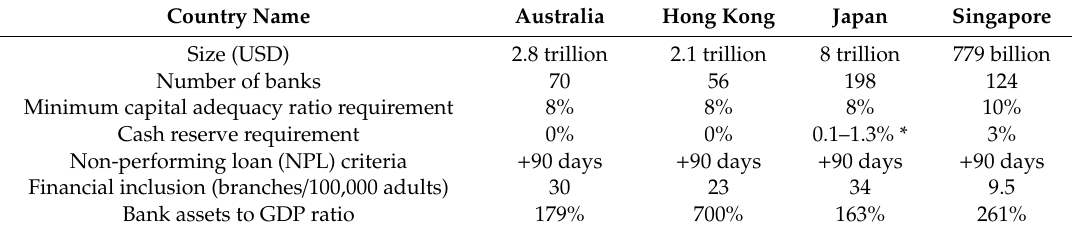
Table 3. Regulatory and institutional characteristics of banking systems in developed